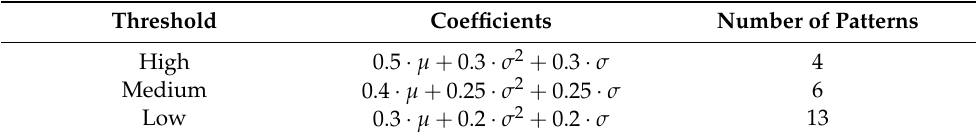
Table 5. Thresholds in